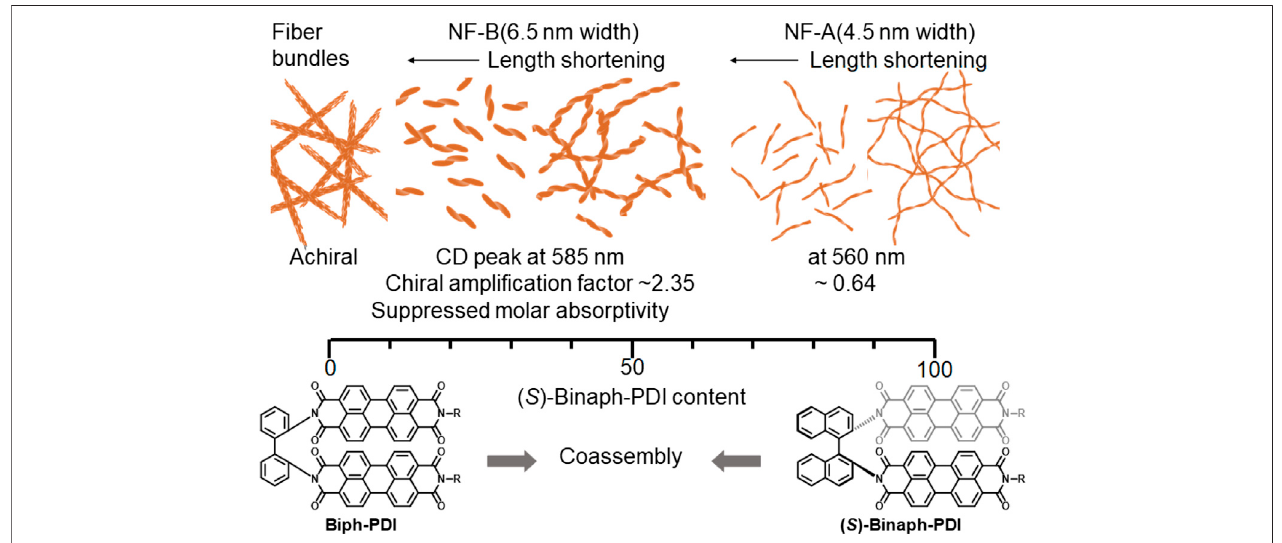
FIGURE 7 | Schematic illustration of supramolecular copolymerization of Biph-PDI and ( S )-Binaph-PDI.